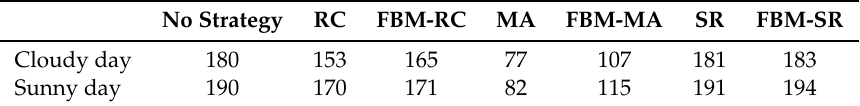
Table 6. Number ramp sign variations for each strategy in both cases.